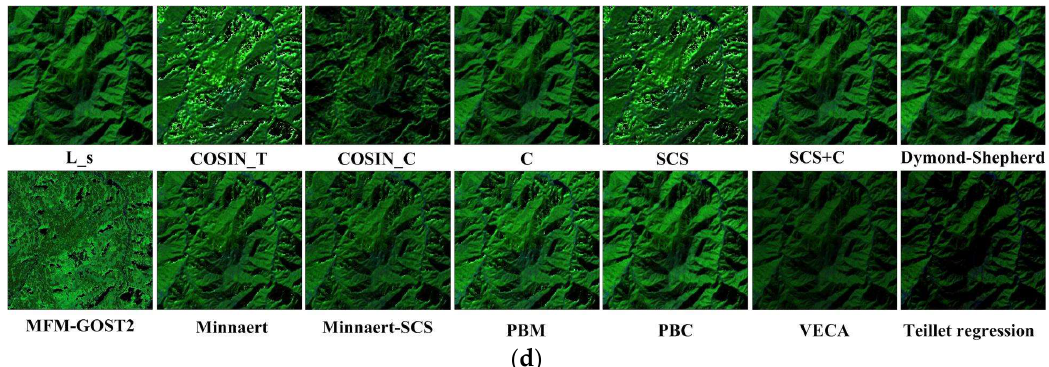
Figure 4. The original and corrected images by MFM-GOST2 and the twelve topographic correction methods. ( a ) is in the red band (Landsat-8 OLI band 4); ( b ) is in the NIR band (Landsat-8 OLI band 5); ( c ) is in the SWIR band (Landsat-8 OLI band 6); and ( d ) is the false color composites of Landsat-8 OLI (band 6-5-4). Radiances of the false color composites images were multiplied by 2.5 for improving the visually inspection. L_s is the uncorrected image.